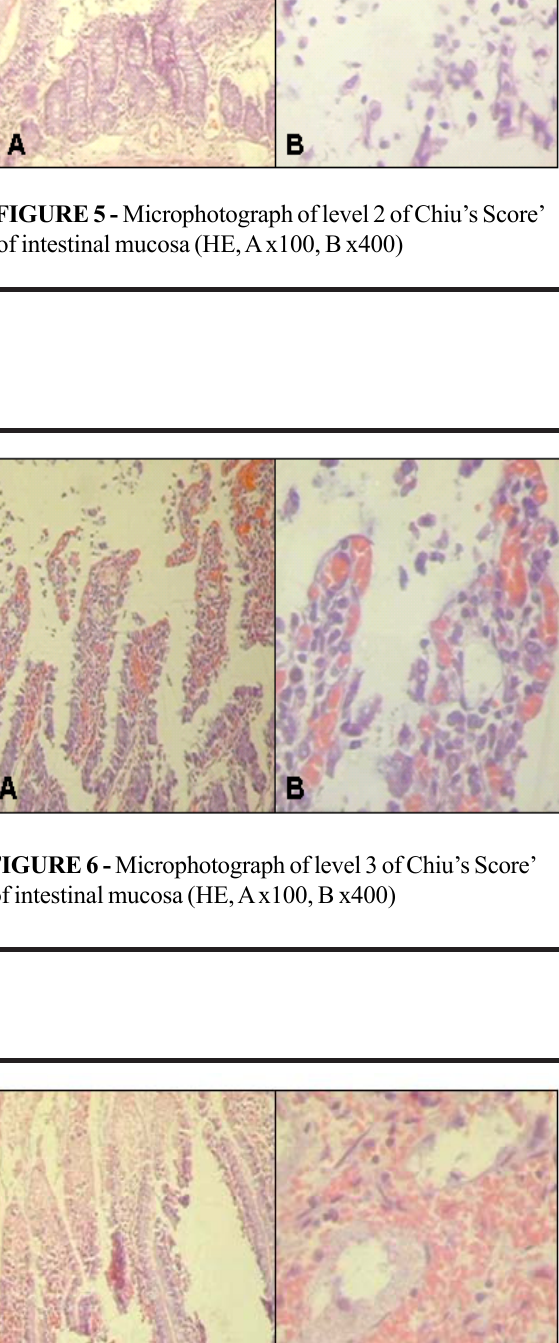
FIGURE 6 - Microphotograph of level 3 of Chiu’s Score 6 of intestinal mucosa (HE, A x100, B x400) FIGURE 4 - Microphotograph of level 1 of Chiu’s Score’ of intestinal mucosa (HE, A x100, B x400)